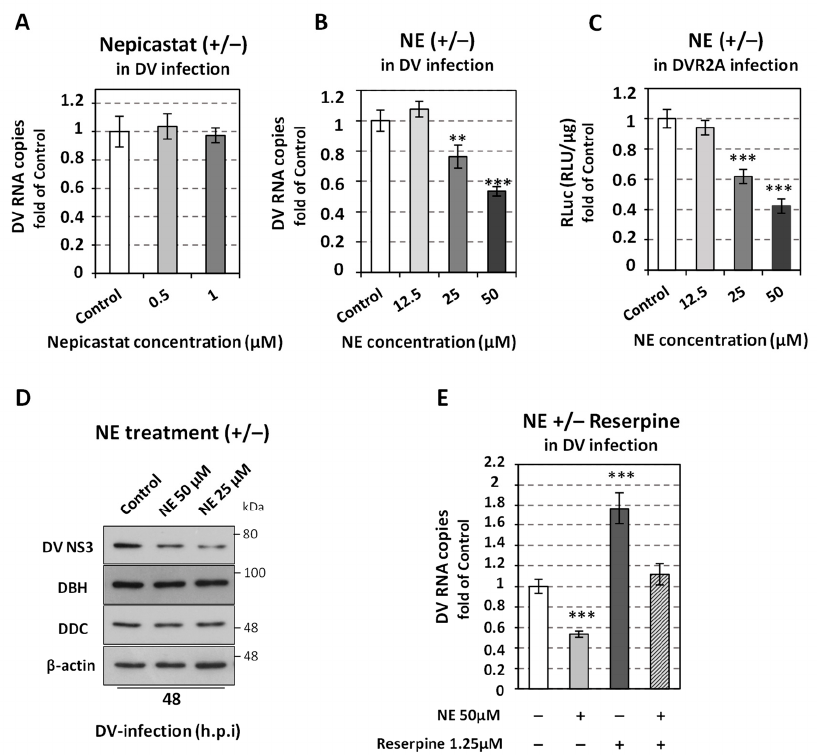
Figure 7. DBH inhibition (nepicastat) has no effect on DV replication, in contrast, to the inhibitory effect exerted by the DBH product, NE. After a 4 h inoculation of Huh7 cells with the non-reporter DV (MOI = 0.1) ( A , B , D , E ) or reporter DVR2A (MOI = 0.1) ( C ) and subsequent inoculum removal, cells were treated with different concentrations of nepicastat ( A ) or NE ( B – E ) or were mock-treated (Control) for 48 h. ( A , B ) RT-qPCR analysis was performed to determine DV plus-strand RNA levels in cells subjected to nepicastat ( A ) or NE ( B ) treatment, or in mock-treated (Control) cells. ** p < 0.01, *** p < 0.001 vs. Control. ( C ) Renilla luciferase activity, indicative of dengue virus replication, was determined in NE treated or mock-treated (Control) cells. Infected mock-treated cell values were set as one. The mean values ± standard deviations from three independent experiments in triplicate are featured. *** p < 0.001 vs. Control. ( D ) SDS-PAGE and immunoblot analysis were carried out in lysates of cells infected by DV and subsequently treated with NE or mock-treated (Control) for 48h. Antibodies detecting DV NS3, DBH, DDC or β -actin (loading control) proteins were used. An experiment that is representative of three independent repetitions is presented. ( E ) Effect of co-treatment with NE and reserpine on DV genome replication. RT-qPCR analysis was utilized to quantify plus-strand RNA levels of DV that were then normalized to the mRNA levels of the housekeeping gene. Infected mock-treated cell (Control, ( − )) values were set as one. Data shown are means ± standard deviations of values from three independent experiments in triplicate. *** p < 0.001 vs. Control ( −